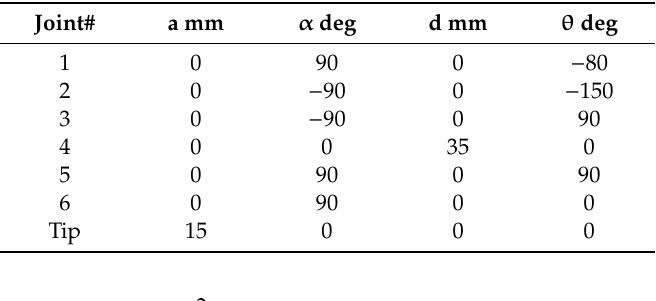
Table 8. Denavit–Hartenberg (DH) parameter of Condition (E). Table 7. Denavit–Hartenberg (DH) parameter of Condition (E).